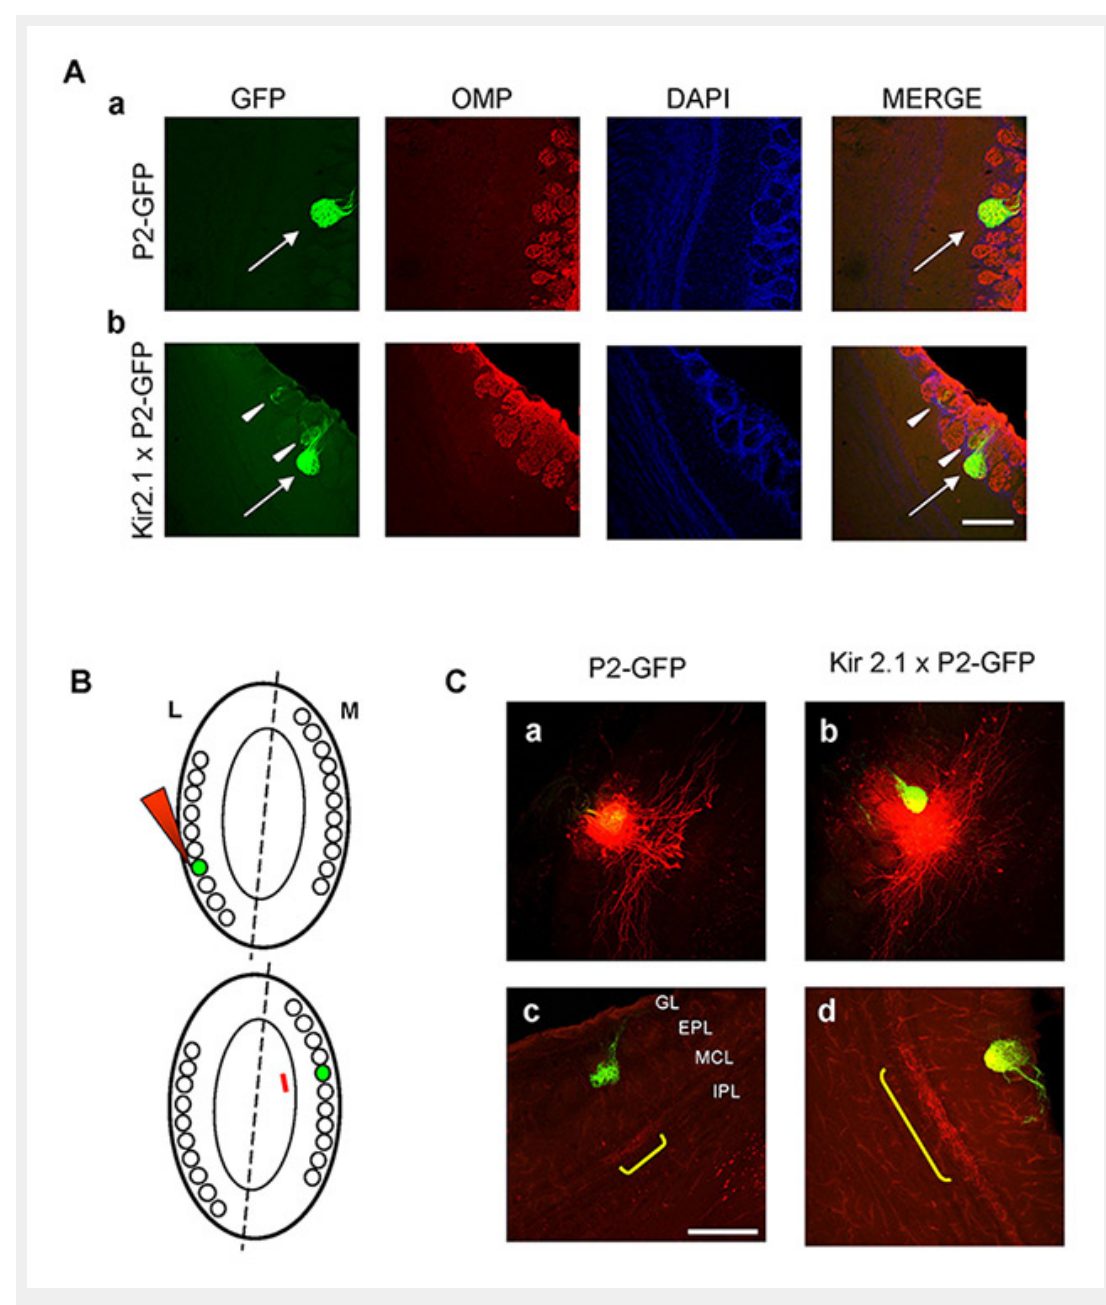
Figure 4 Neuronal wiring in the olfactory bulb of Kir2.1 mice. A. Organisation of glomeruli in control and Kir2.1 mice. Organisation of P2 glomeruli was revealed by immunolabelling horizontal sections of the olfactory bulb (OB) with antibodies against olfactory marker protein (OMP, in red). GFP expressed in P2 axons (green). Nuclei stained by the nuclear marker, DAPI (blue). Aa, Ab, P2-axons coalesce to form glomeruli formed by fibres expressing OMP and GFP, i.e. bearing P2 receptor, in P2-GFP and in Kir2.1 X P2-GFP mice (arrows). Ab, P2-axons innervate also additional adjacent glomeruli formed by fibres expressing GFP and OMP, but also only OMP (i.e. expressing a different receptor than P2, arrowheads) in Kir2.1 X P2-GFP mice. B. Schematic of the experimental procedure. The dashed line indicates line of symmetry between glomerular maps, within each olfactory bulb. Homologous glomeruli are indicated by green labels. The red arrowhead indicates the tracer injection targeted to the lateral glomerulus (top). The red line refers to external tufted cell (ETC) projection just underneath the medial homologous glomerulus on the opposite side of the OB (bottom). C. Intrabulbar circuitry in control and Kir2.1 mice. Examples of focal tracer injections (red spots) targeted to the medial P2-GFP glomerulus in control (a) and Kir2.1 mice (b). ETC axons labelled in (a) and (b) give rise to anterograde projections (yellow brackets) underneath the homologous P2-GFP glomeruli on the opposite side of the olfactory bulb in control (c) and Kir2.1 (d) mice. In Kir2.1 mice the anterograde projection is not confined to the homologous glomerulus, as in controls, but larger (d) (Lorenzon et al., 2015 [76]). Scale bar = 200 µm. EPL = external plexiform layer; GL = glomerular layer; IPL = internal plexiform layer ;MCL = mitral cell